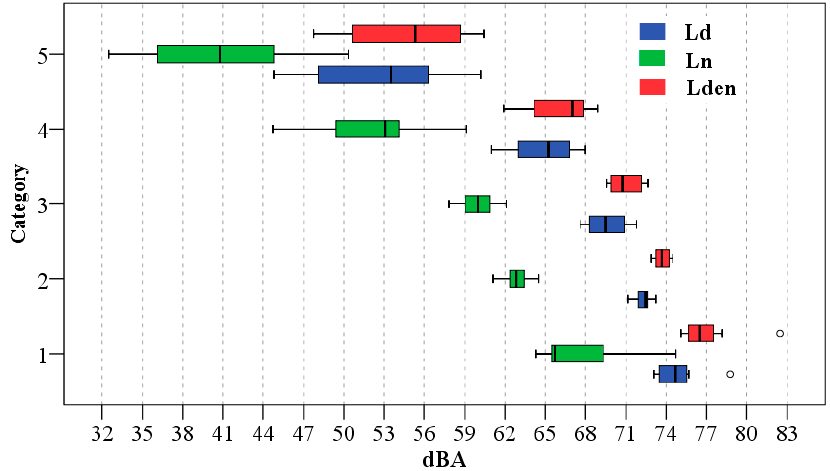
Figure 5. Box plot of L d , L n and L den descriptors registered in each road categories.